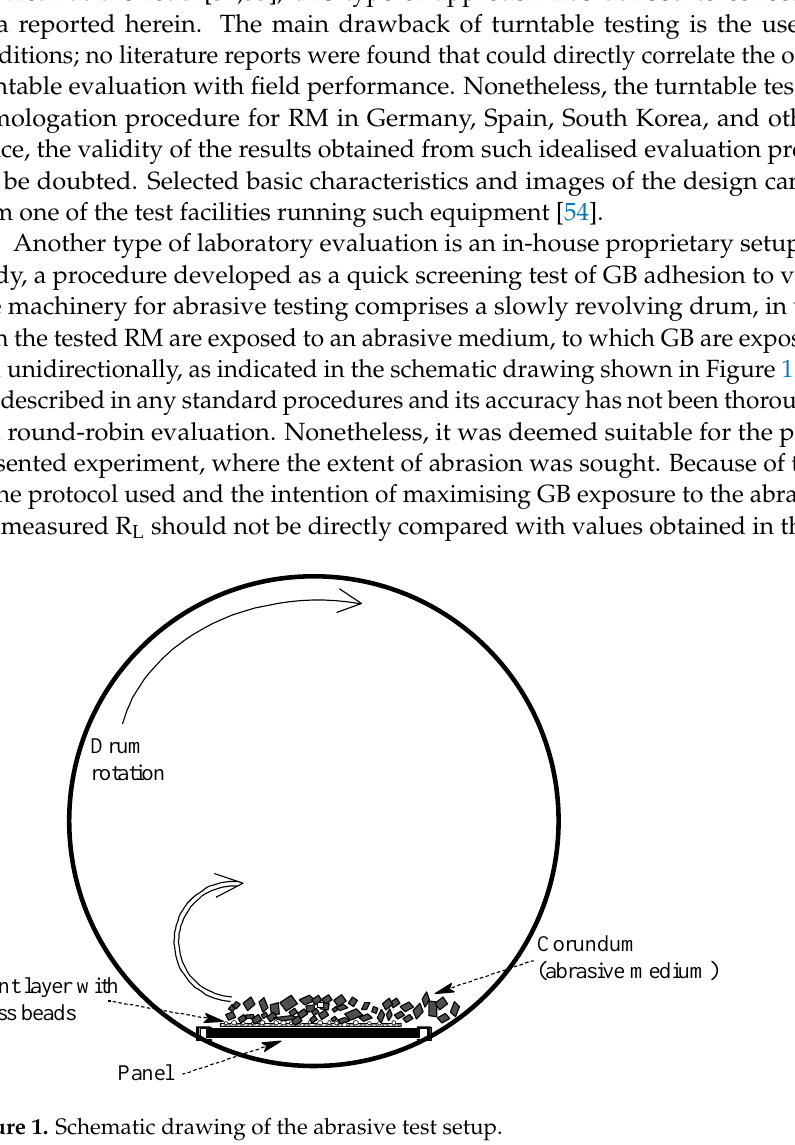
Figure 1. Schematic drawing of the abrasive test setup.